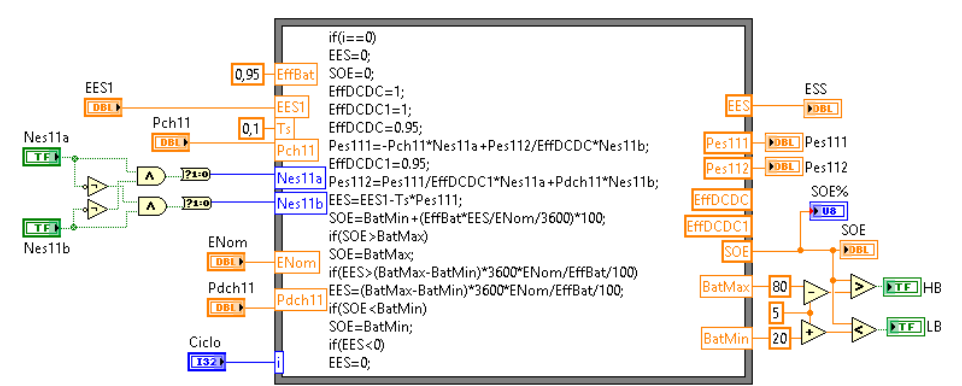
Figure 11. LabVIEW programming for WT generators.